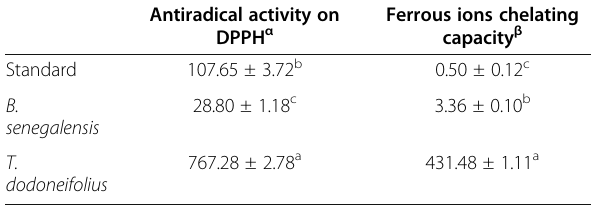
Table 6 IC 50 ( μ g/ml) value of different